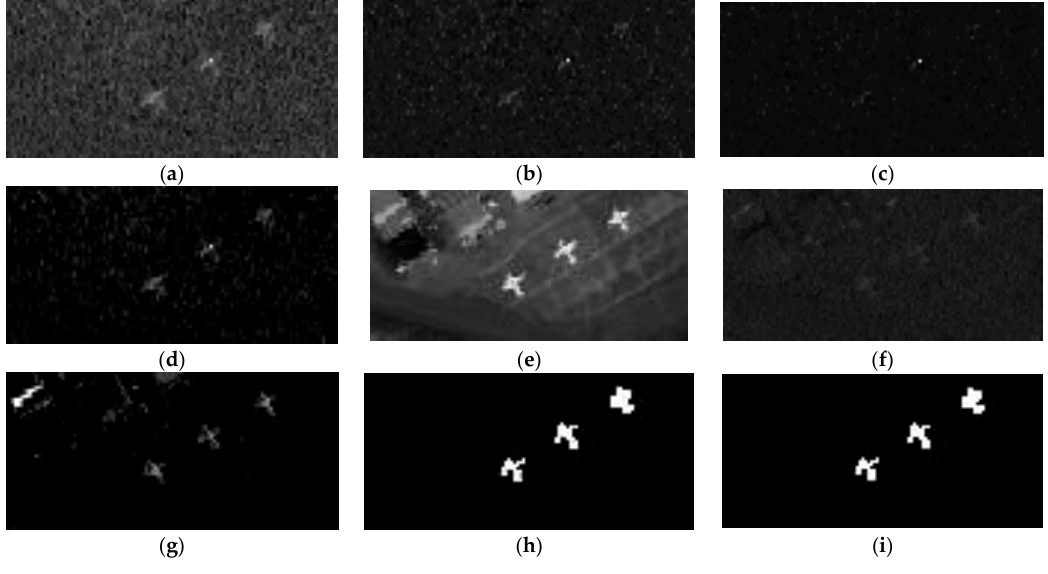
Figure 11. Detection results of the AVIRIS data: ( a – c ) results of the hCEM algorithm for the first to third layers; ( d ) results of CEM algorithm; ( e ) results of SAM algorithm; ( f ) results of CE algorithm; ( g ) results of MPCEM algorithm; ( h ) results of SWCEM algorithm; and ( i ) reference data.